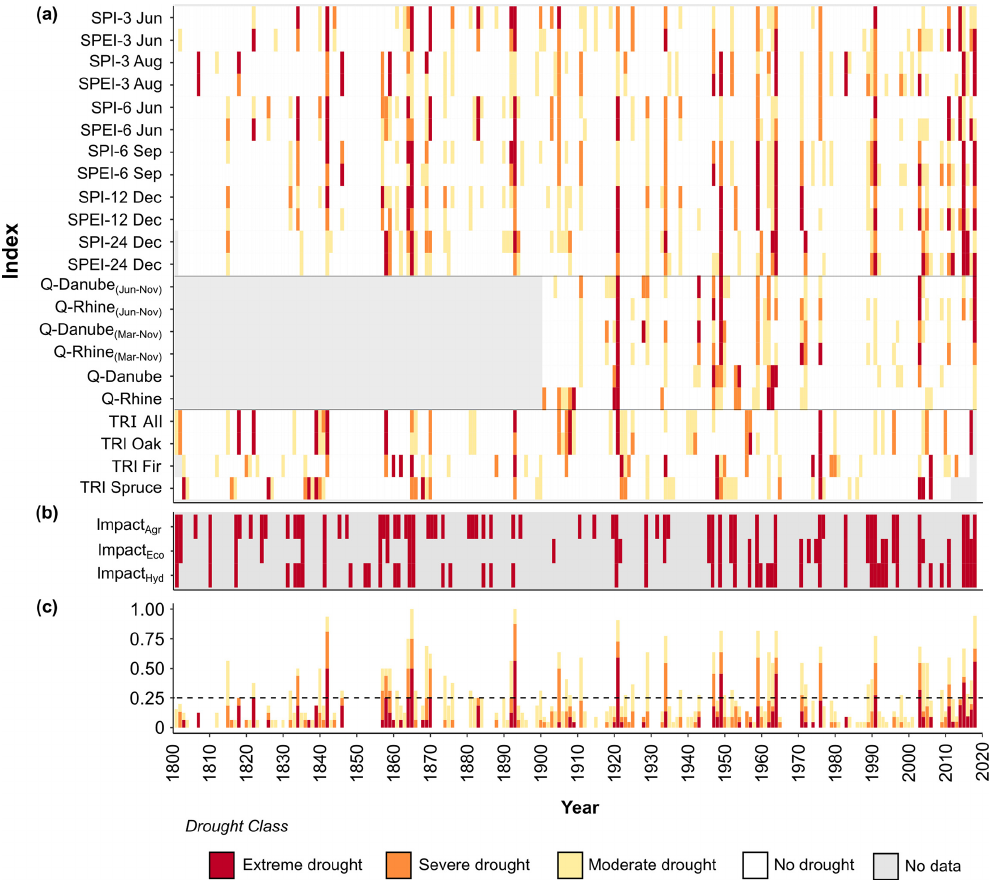
Figure 3. Annual time series of drought occurrence in southwestern Germany according to different groups of indices: (a) hydrometeorolog- ical drought indices and tree-ring data, (b) drought impacts, and (c) the combined drought index C1, which shows the annual percentage of indices indicating droughts (impacts are